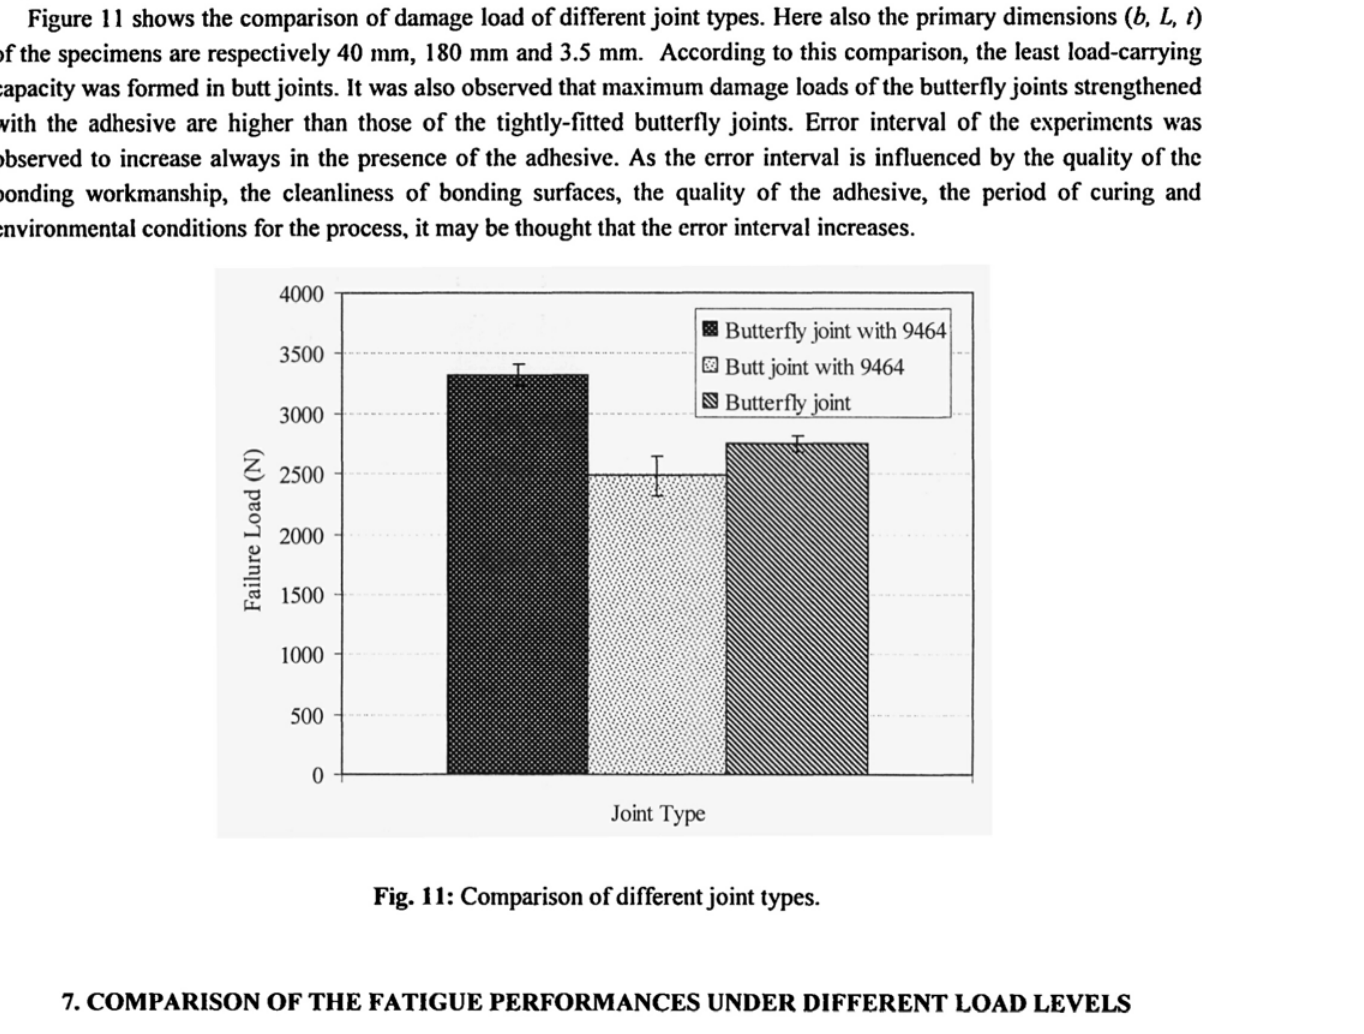
Fig. 11: Comparison of different joint